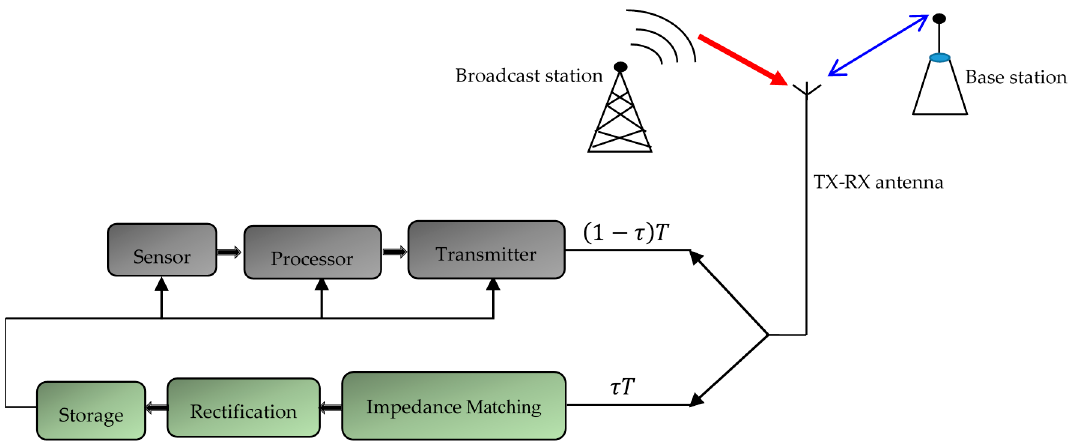
Figure 1. Conceptual view of enslaved sensor node.